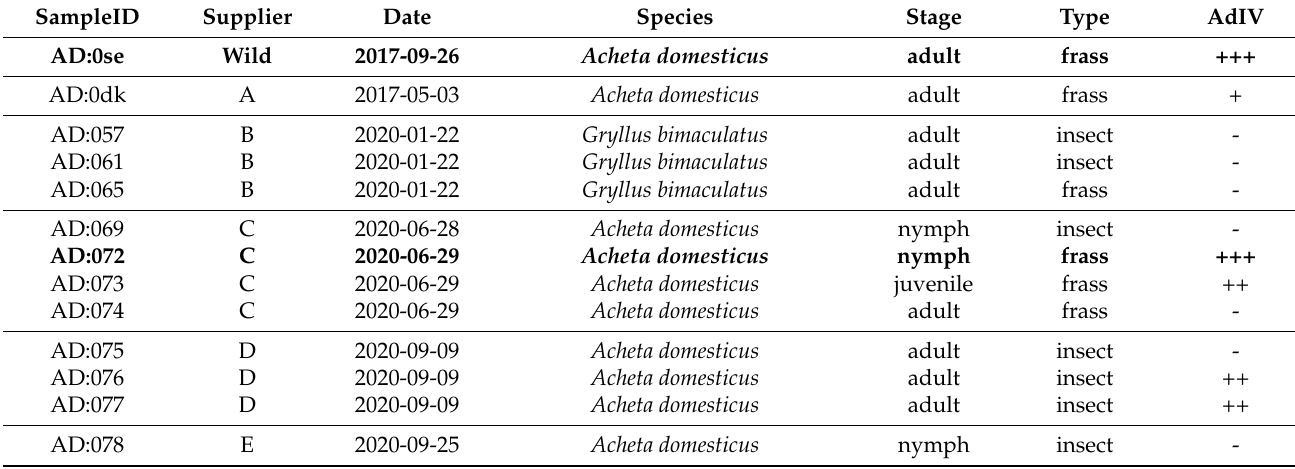
Table 1. Sample origins and Acheta domesticus Iflavirus (AdIV) status. Details of the samples analysed in the study, including the sample ID, the supplier of the samples (retailer or breeder), the date the sample was received, the species and developmental stage of the crickets, the sample type analysed, and the semi-quantitative results of the AdIV RT-qPCR test, with ‘-‘ indicating a negative result and ‘+’, ‘++’, and ‘+++’ indicating various levels of positive results. Samples AD:0se and AD:072 ( bold ) were used to obtain the full AdIV genome sequences of the two strains. For the other positive samples, the strain was identified by amplifying and sequencing a fragment of the helicase